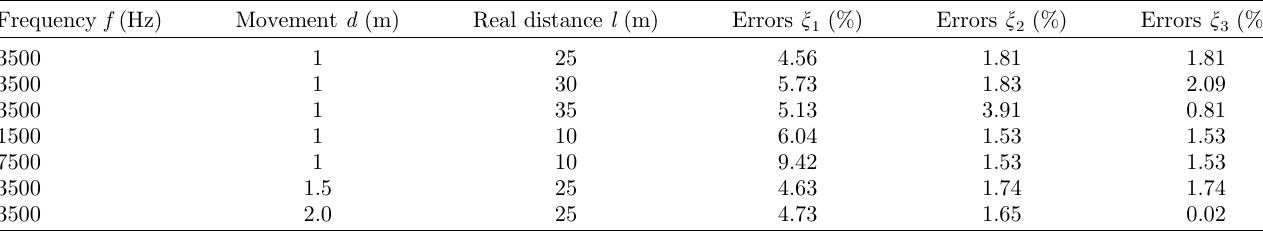
Table 5. The errors of rearranged Luneburg lens for sound localization. Frequency f